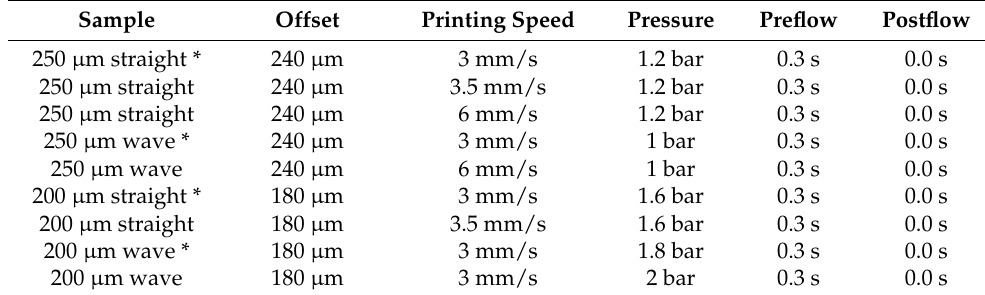
Table 1. Printing parameters for the different scaffolds.